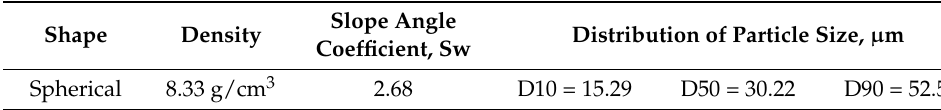
Table 2. Properties of Co-Cr-Mo alloy powder.